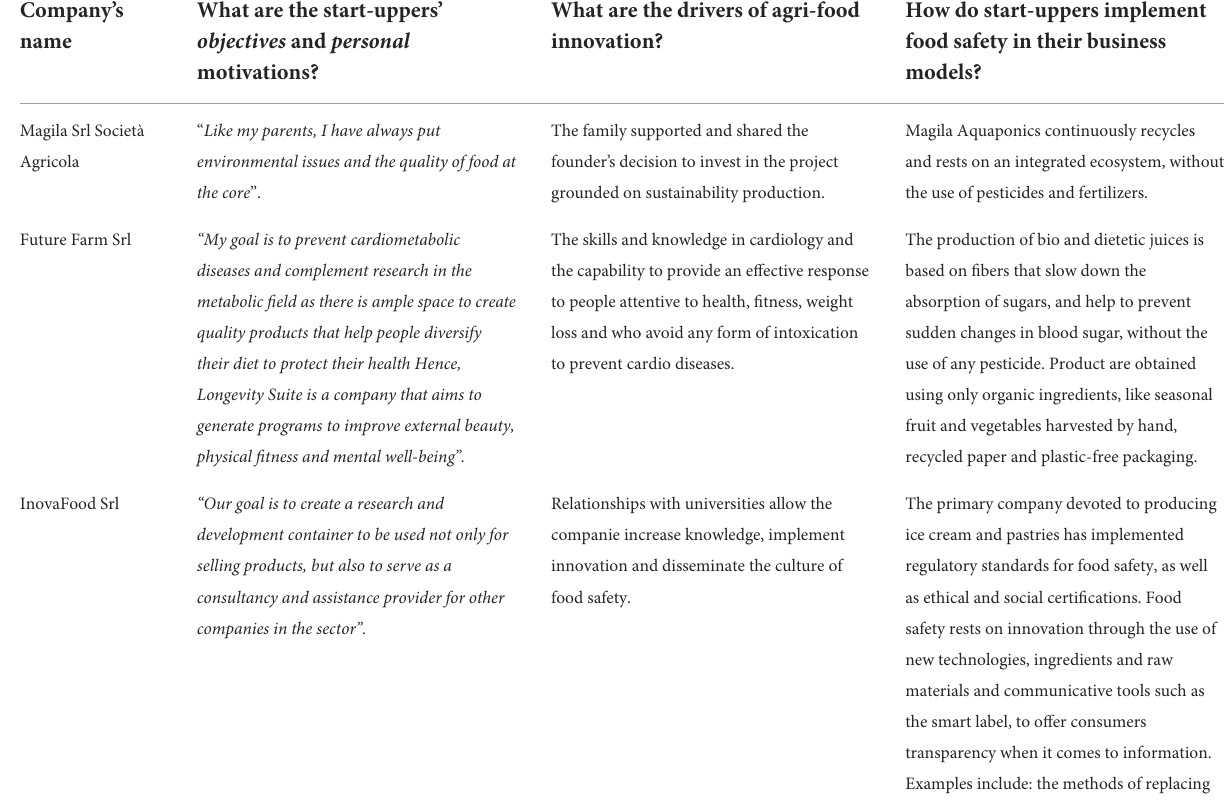
TABLE 2 Main findings